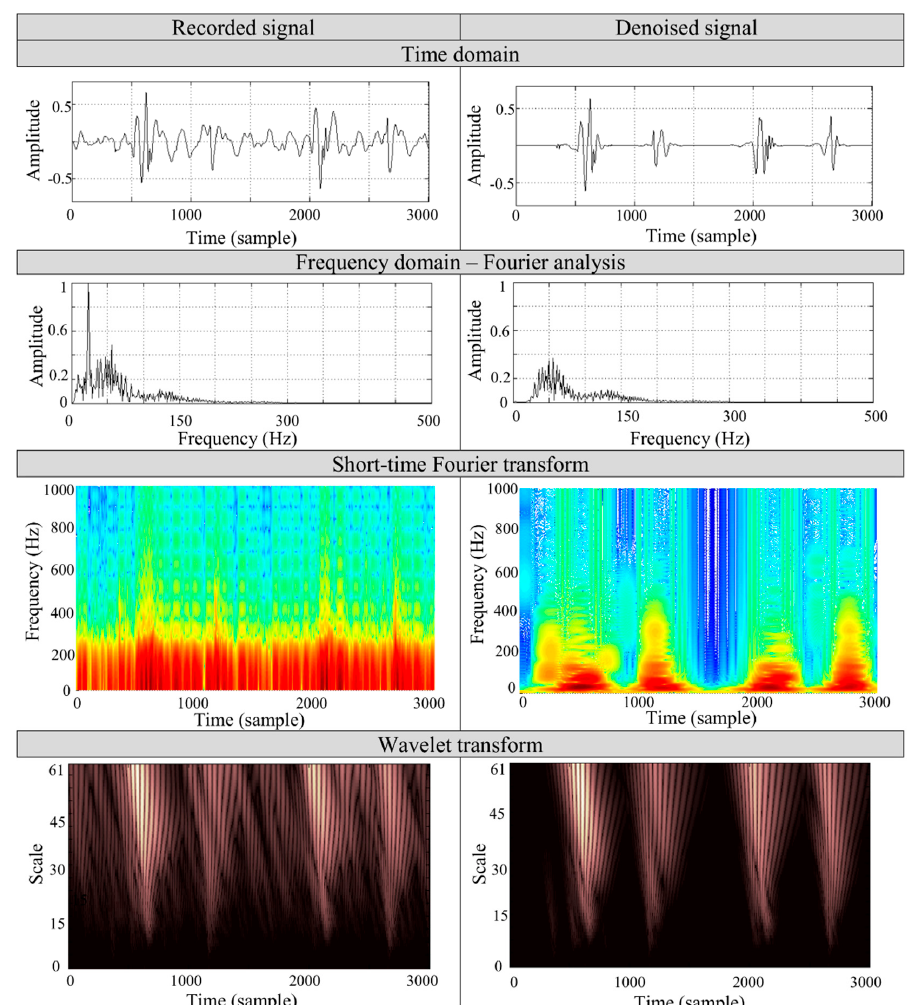
Figure 7. The results of the denoising of real PCG signal containing of two heart cycles recorded in a noisy environment by mobile devices with corresponding spectrum analysis.